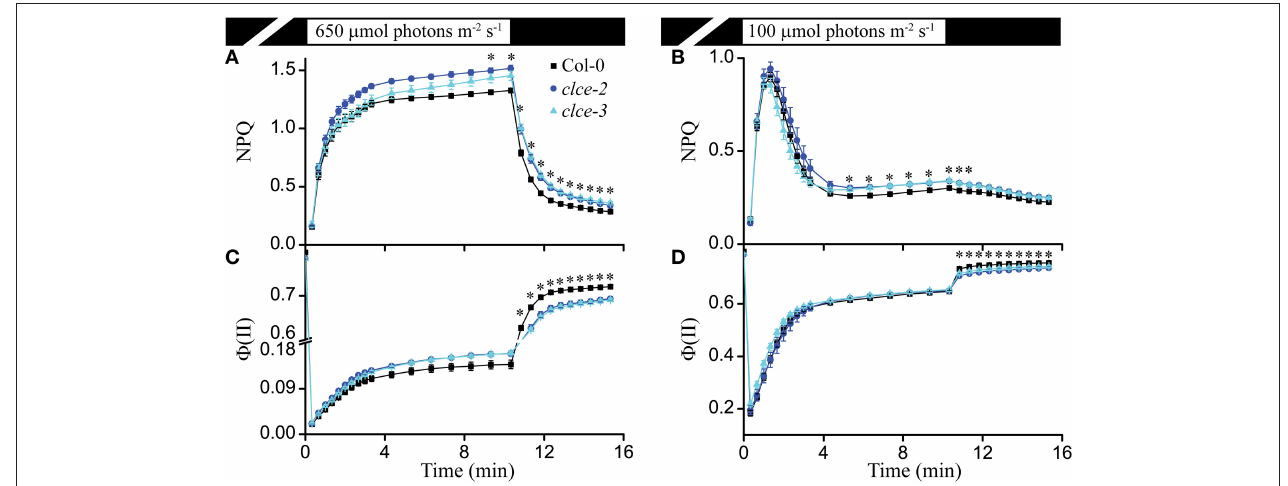
FIGURE 4 | Non-photochemical quenching ( NPQ ) and PSII efficiency [ 8 (II )]. NPQ induction kinetics of wild-type and clce plants were recorded during illumination for 10min at 650 µ mol photons m − 2 s − 1 (A) or 100 µ mol photons m − 2 s − 1 (B) followed by 5min relaxation in darkness. Φ ( II ) from the same set of measurements is plotted in (C,D) . The plotted data are means ± SEM ( n = 9 plants). Asterisks indicate statistically significant differences according to ANOVA ( P < 0.05